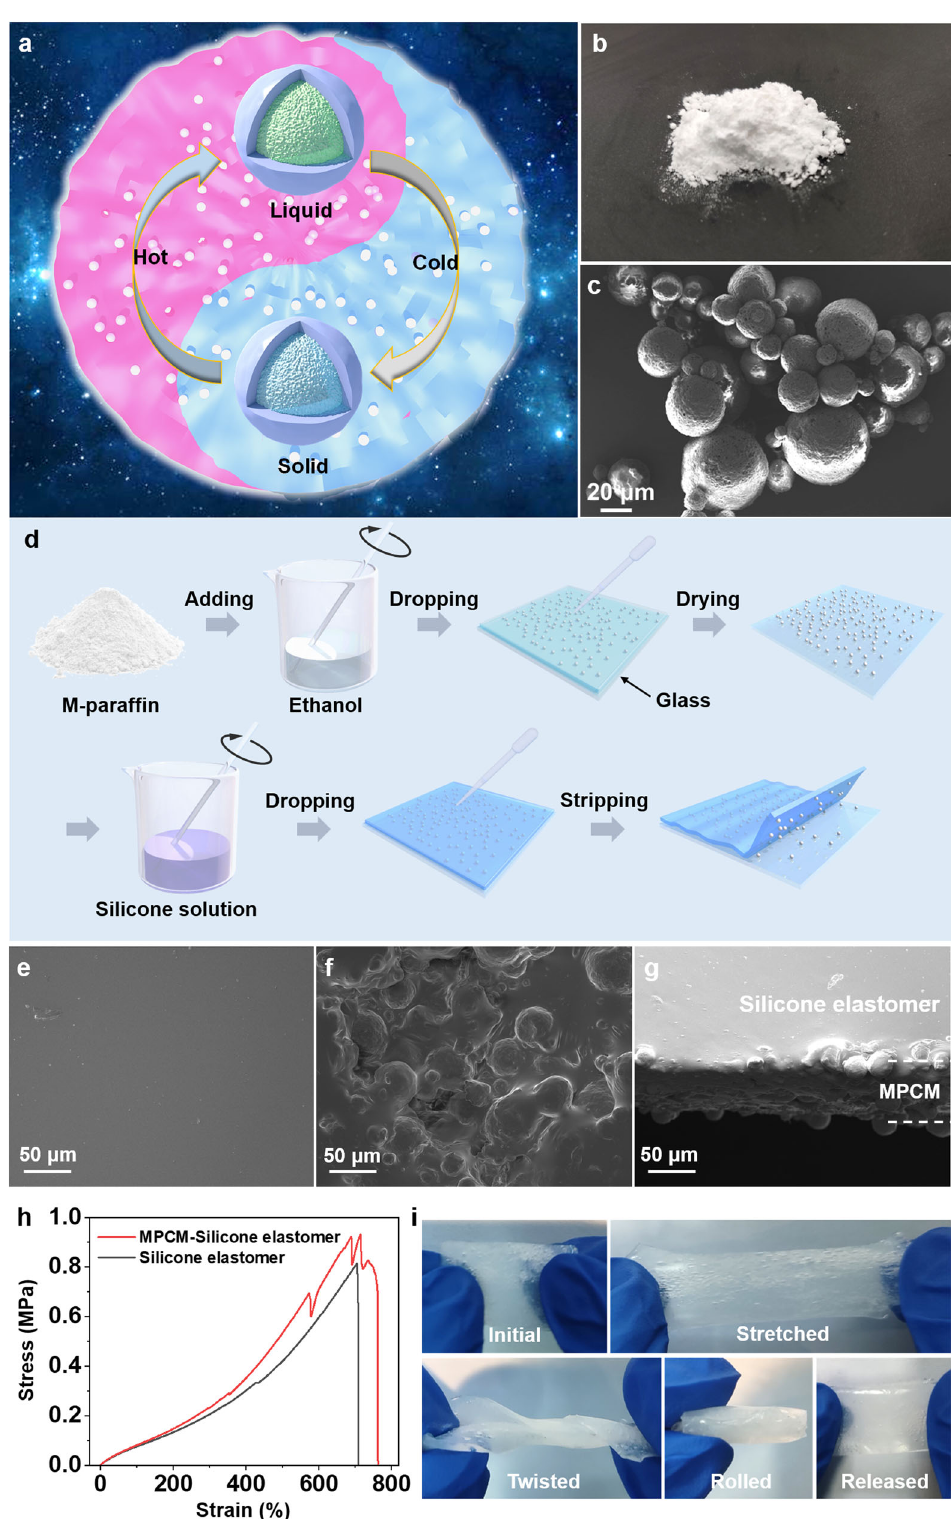
Fig. 1 Preparation and mechanical properties of ME-skin. a Schematic of ME-skin with thermoregulating ability based on M-paraf fi n. b Photograph of M-paraf fi n. c The SEM image of M-paraf fi n. Scale bar: 20 μ m. d Detailed preparation process of ME-skin. e – g The SEM image of ME-skin with front, back, and cross-section. Scale bar: 50 μ m. h Stress-strain curves of ME-skin and silicone elastomer. i The mechanical deformation capacity of a 10 × 15 mm ME-skin. Images of the initial state, stretching, twisting, rolling, and release